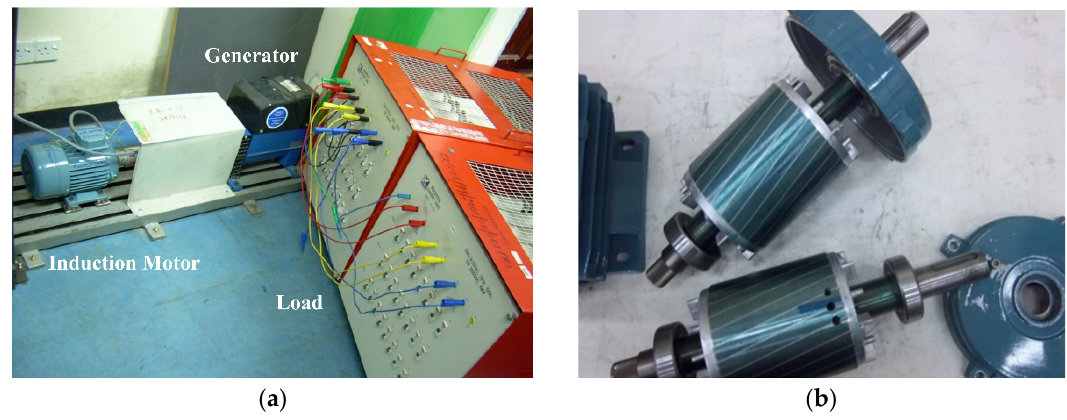
Figure 2. ( a ) Experimental test rig and ( b ) Demonstration of the healthy and rotor with three broken bars. broken